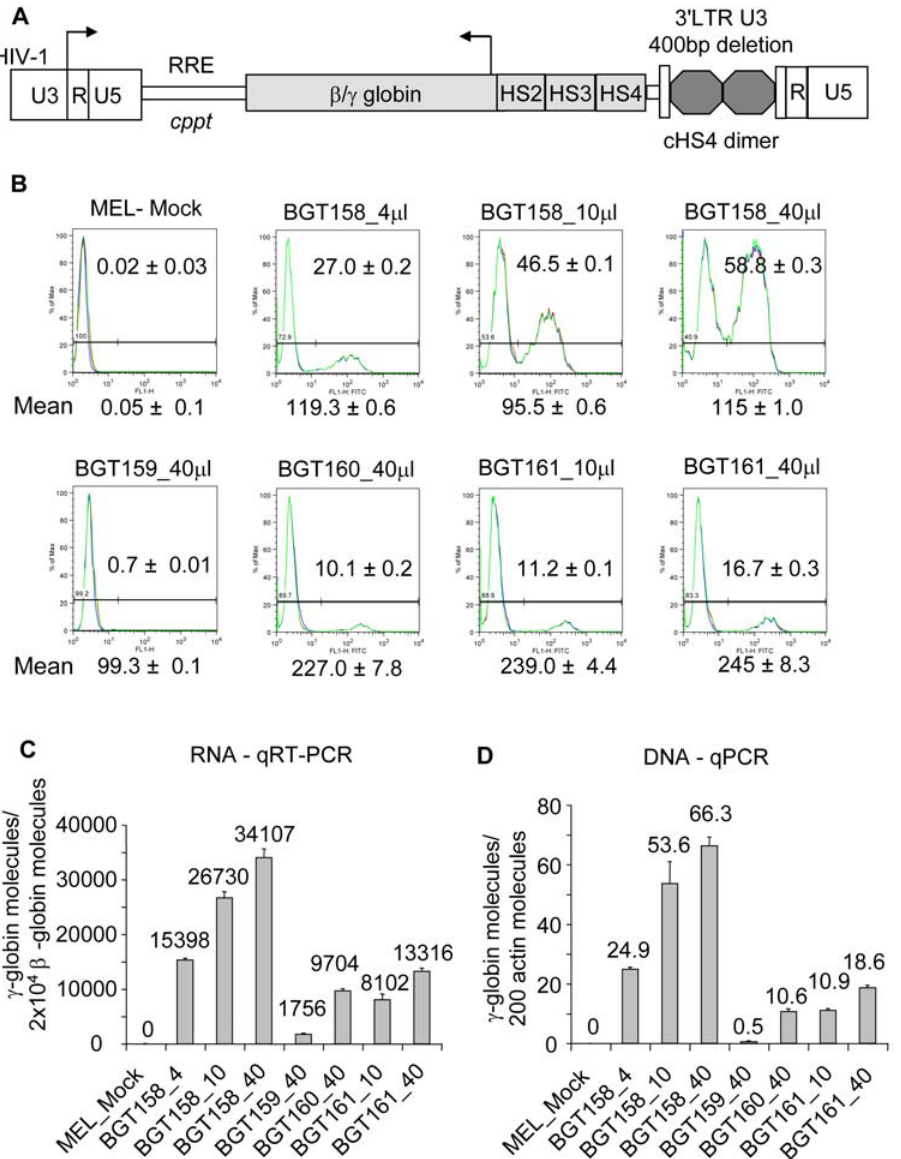
Figure 10. Increased titer by the BGT158 intron 2 and complementation by other HS elements. (A) Map of the PL.SIN.cHS4 lentivirus showing the LCR (5 9 HS2-4) b / c -globin transgene and other components described in Figure 9. BGT159 contains the wild-type intron 2 from BGT50, BGT160 contains the BGT64 intron 2 with the deleted ATR (Figure 1A), and BGT161 contains the BGT158 modified intron 2 (Figure 1B). (B) The presence of 5 9 HS4 and 5 9 HS2 compensates for the absence of the intron 2 ATR in BGT160. BGT160 expresses high mean A c -globin protein levels assessed by flow cytometry of MEL cells performed in triplicate 6 SE after 6 days induction with HMBA. The presence of the BGT158 modified intron 2 in BGT161 increases the viral titer but not the MFI. (C) qRT-PCR results in triplicate 6 SE were performed on the infected MEL cells after 3 days induction with HMBA. RNA expression is shown as A c -globin molecules per 2 6 10 4 mouse b major-globin molecules after correction for the lentivirus copy number. (D) The lentivirus copy number (detected by qPCR analysis as described in Figure 9D) is approximately equal to the % of A c -globin + cells detected by flow cytometry. Using different combinations of intronic elements, we show that the Oct-1 site cooperates with the b -globin intronic enhancer to raise the mean level of expression in transgenic mice, and that the Ig m at single copy integration sites. The BGT158 construct containing all of these elements shows good induction in erythroid cells with